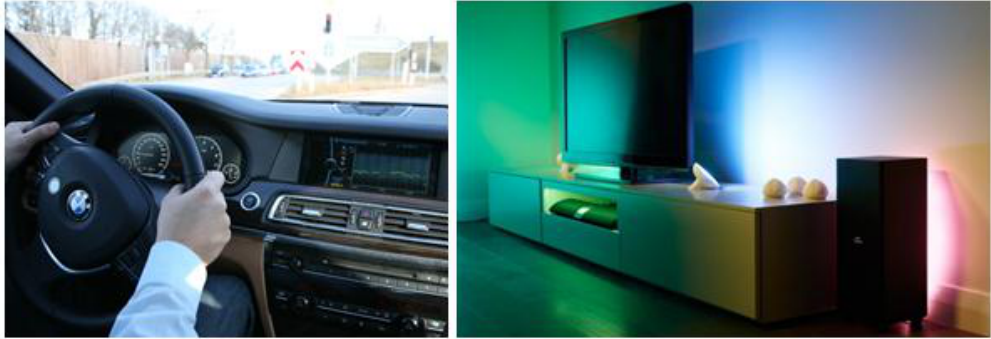
Figure 7. Smart Steering Wheel to measure Driver Vital Signs and Smarthome Connected Lighting signals when it is “Time to Leave” for an appointment